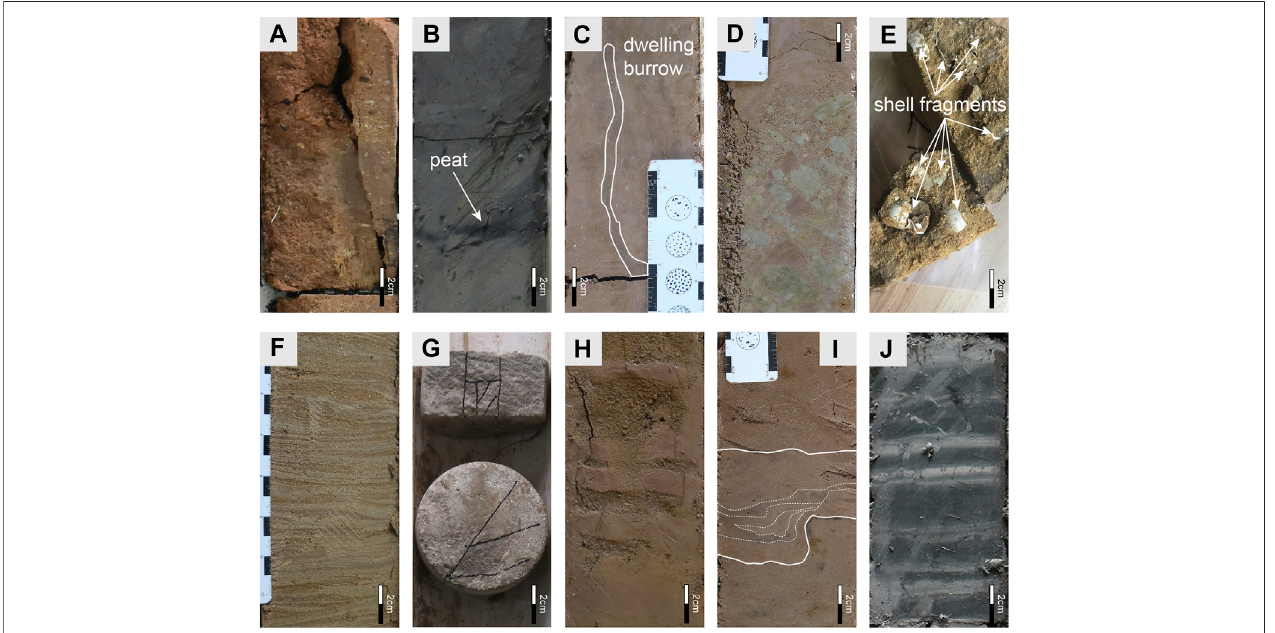
FIGURE 2 | Photographs of typical sedimentary features in ZK01 core. (A) Paleosol in Xiatuhe Formation (Xt Fm.). (B) Black organic-rich clay in Xiaobai Formation (Xb Fm.). Note the peat layer to which the arrow points. (C) Mud- fi lled dwelling burrow in Hongya Formation (Hy Fm.). (D) Mud clasts in Hy Fm., with rough normal- grading. (E) Shell fragments in Dagou Formation (Dg Fm.). (F) Wavy beddings of sand and clayey silt in Mugua Formation (Mg Fm.). (G) Rigid and compact calcareous cement in Fenhe Formation (Fh Fm.). (H) Contorted beds commonly seen on delta front. (I) Tidal rhythmite consisting of silts and muds. (J) Lacustrine rhythmite of pale carbonate-rich and dark organic-rich strati fi